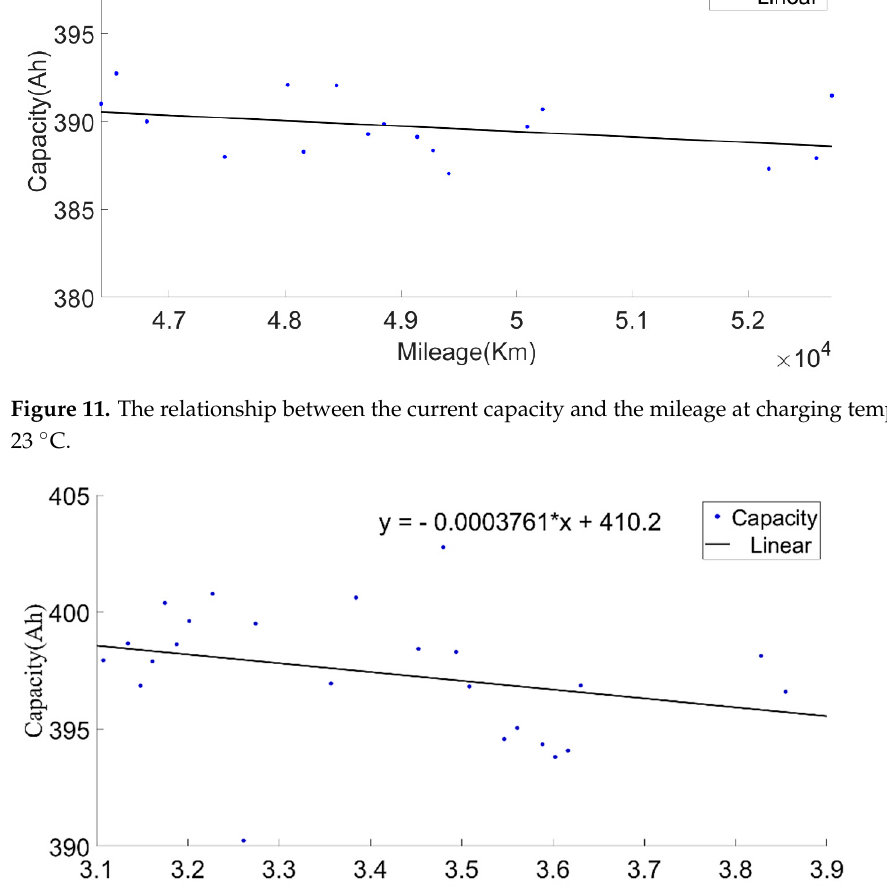
Figure 14. The relationship between the discharging temperature, discharging current and the mile- age at the charging temperature of 23 °C. Figure 15. The relationship between the discharging temperature, discharging current and the mile- age at the charging temperature of 25 °C.